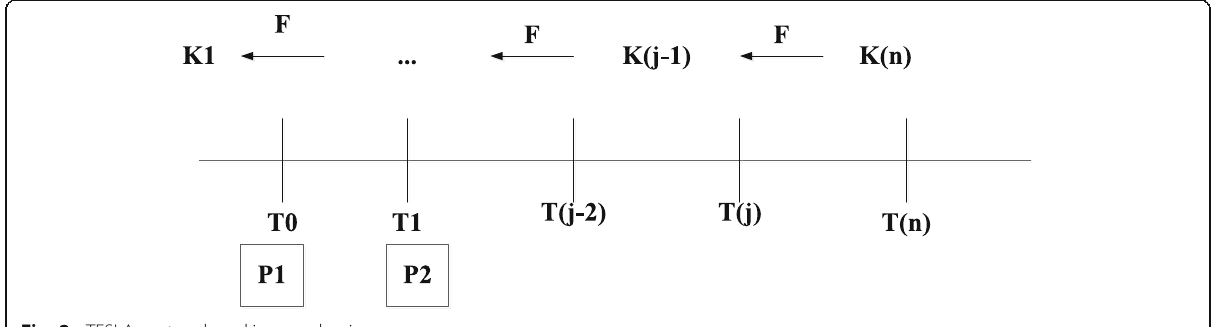
Fig. 2 μ TESLA protocol working mechanism